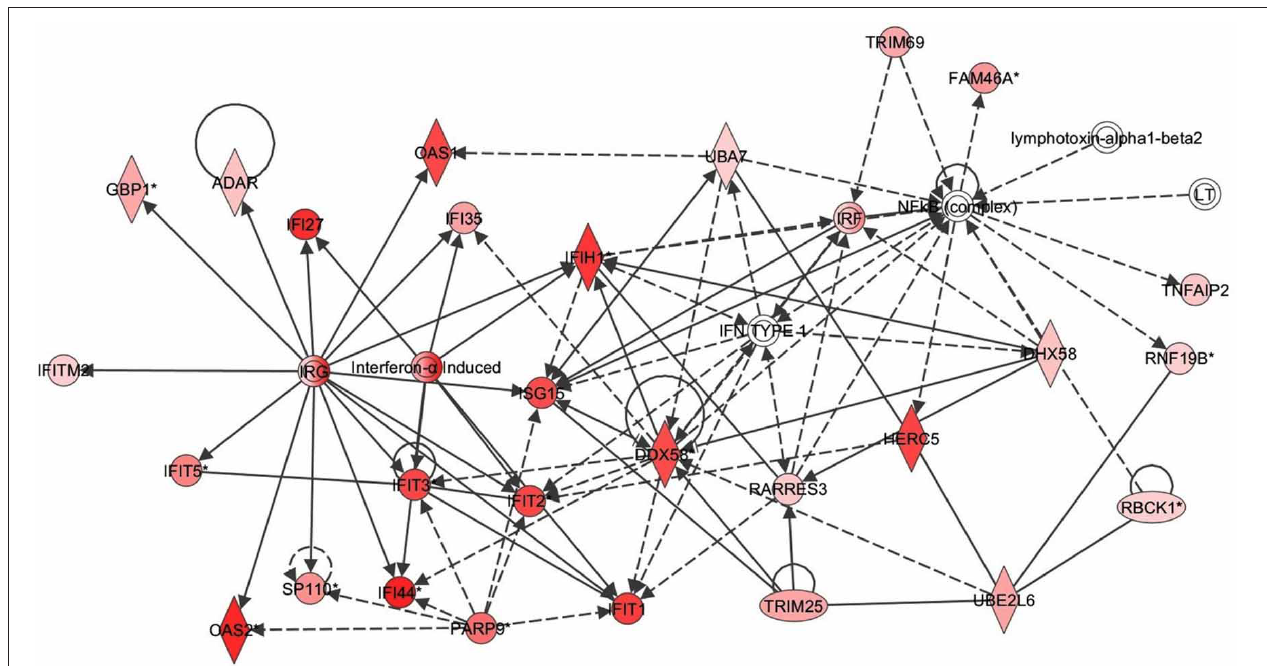
FIGURE 4 | Interferon response gene network in respiratory epithelial cells exposed to Alternaria alternata spores. Genes that are significantly up-regulated are shown in red. The intensity of red corresponds to an increase in fold change levels of